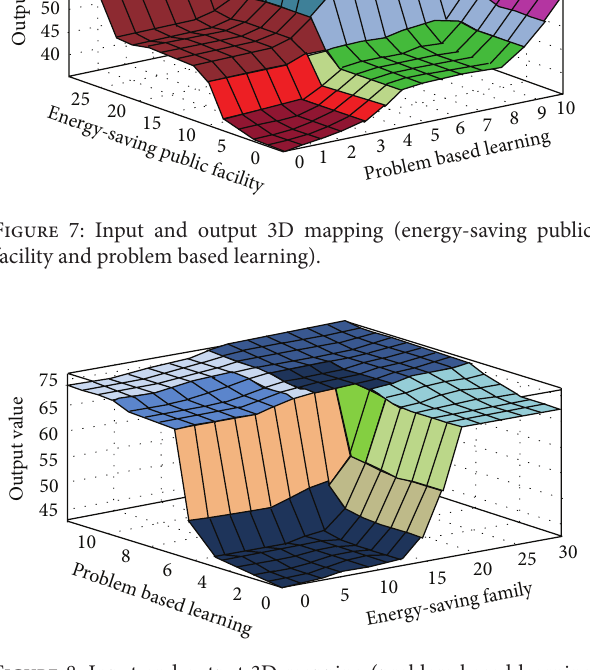
Figure 8: Input and output 3D mapping (problem based learning and energy-saving family).